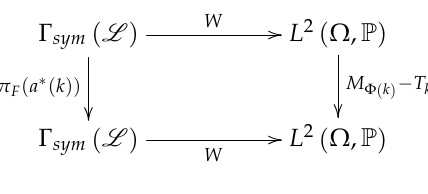
Figure 3. The second